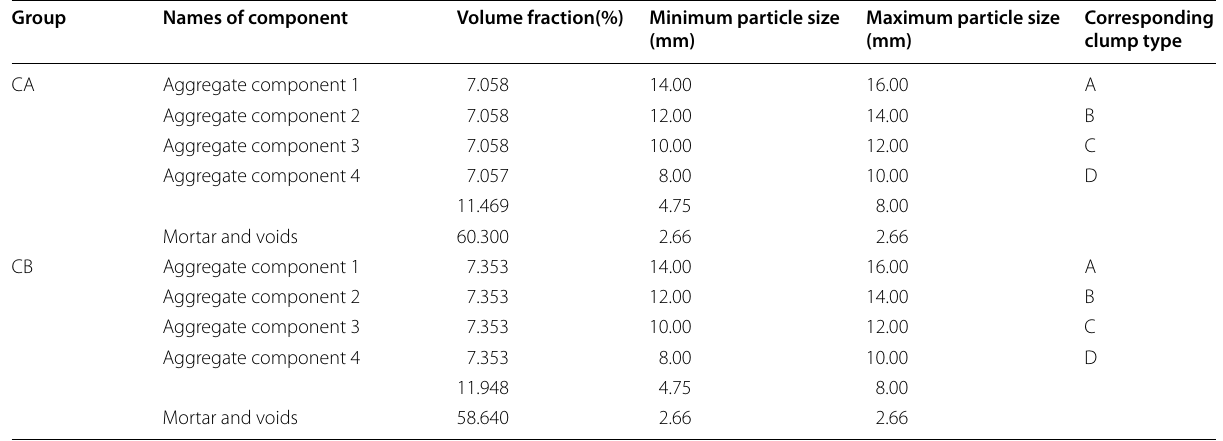
Table 2 Parameters of each